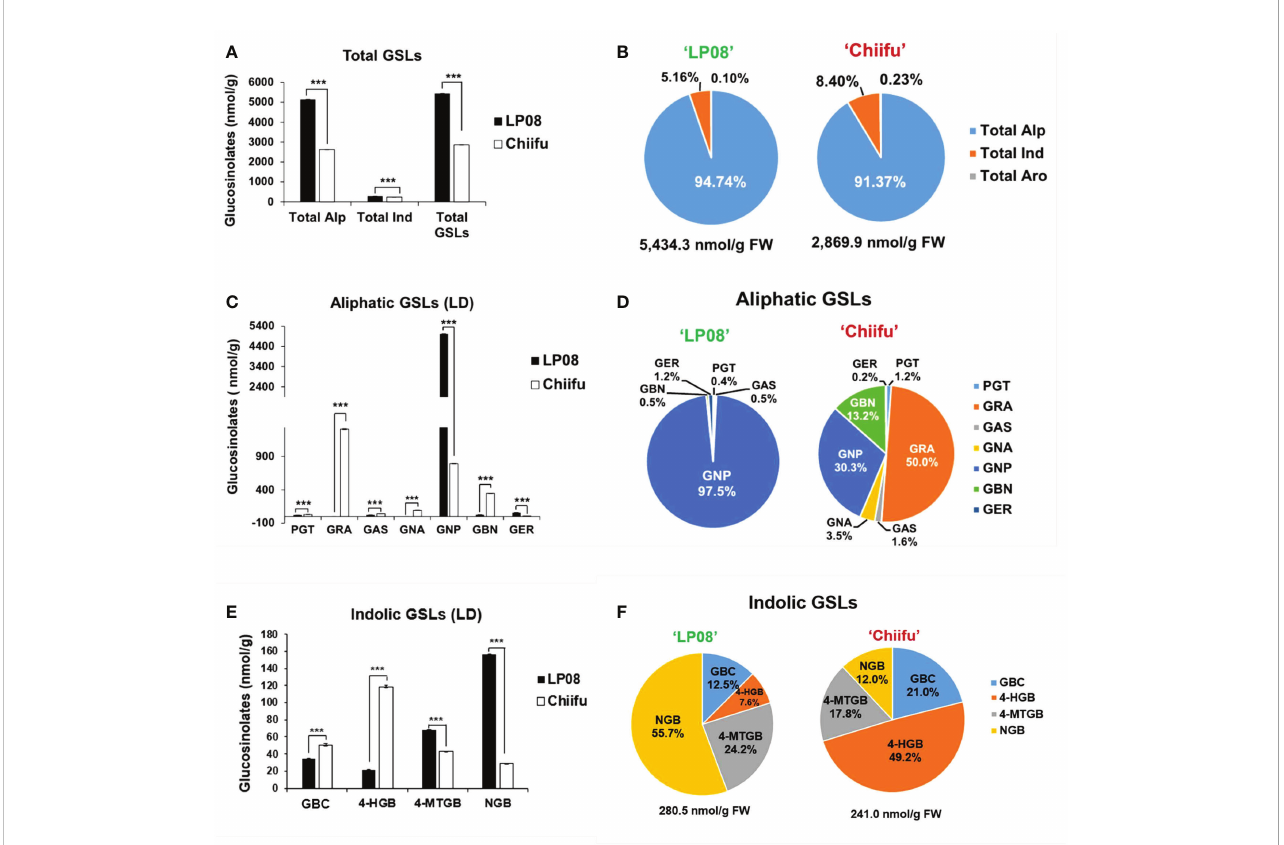
FIGURE 1 Measurement of GSL compounds in ‘ Chiifu ’ and ‘ LP08 ’ . (A) Comparison of total GSL amounts (aliphatic, indolic, and aromatic GSL compounds) in ‘ Chiifu ’ and ‘ LP08 ’ plants grown under long-day (LD) growth conditions. (B) Pie charts showing aliphatic (Alp), indolic (Ind), and aromatic (Aro) GSL compounds as percentages of total GSL content. Aliphatic GSL compounds constituted the majority of the GSLs in both the ‘ Chiifu ’ and ‘ LP08 ’ lines. (C) Bar graph showing the amounts of seven aliphatic GSL compounds in ‘ Chiifu ’ and ‘ LP08 ’ . Student ’ s t -test was used to calculate statistically signi fi cant differences (***p ≤ 0.001). (D) Pie charts showing the amounts of individual aliphatic GSLs in ‘ Chiifu ’ and ‘ LP08 ’ . PGT, progoitrin; GRA, glucoraphanin; GAS, glucoalyssin; GNA, gluconapoleiferin; GNP, gluconapin; GBN, glucobrassicanapin; and GER, glucoerucin (E) Bar graph showing the amounts of four indolic GSL compounds in ‘ Chiifu ’ and ‘ LP08 ’ . (F) Pie charts showing the amounts of four indolic GSL compounds in ‘ Chiifu ’ and ‘ LP08 ’ . GBC, glucobrassicin; 4-HGB, 4-hydroxyglucobrassicin; 4-MTGB, 4-methoxyglucobrassicin; NGB,